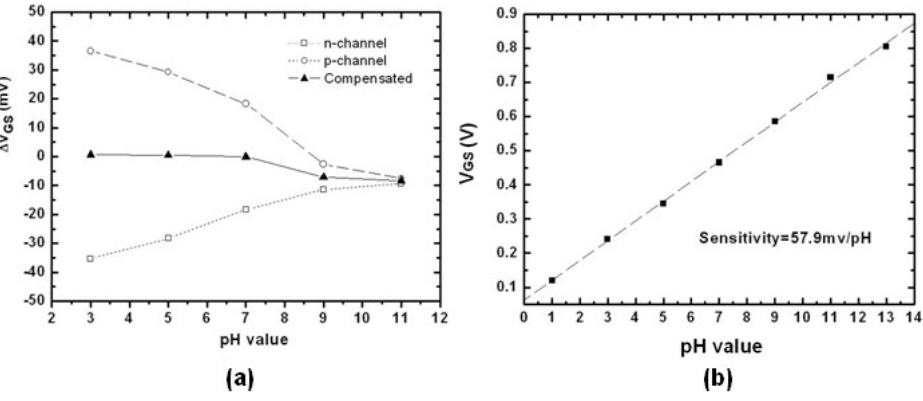
Figure 8. (a) The pH-dependent drift of n-channel, p-channel and corrective ISFETs measured at the seventh hour. (b) The pH sensitivities with the proposed compensation